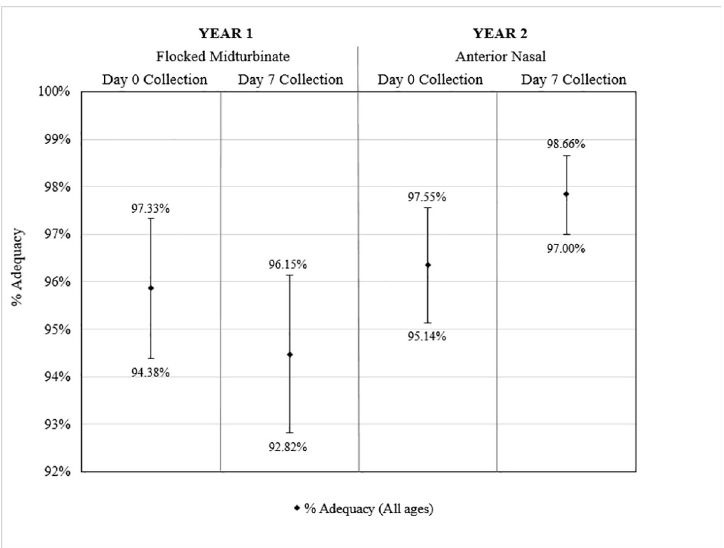
Fig 6. Adequacies of participant-collected respiratory specimens on Day 0 and Day 7 of the Household Study. Bars present the 95% confidence intervals for the percentage of adequate samples (Ct < 38) of (from left to right) participant-collected midturbinate specimens from participants of all ages in Year 1 on Day 0, participant-collected midturbinate specimens from participants of all ages in Year 1 on Day 7, participant-collected anterior nasal specimens from participants of all ages in Year 2 on Day 0, and participant-collected anterior nasal specimens from participants of all ages in Year 2 on Day 7.